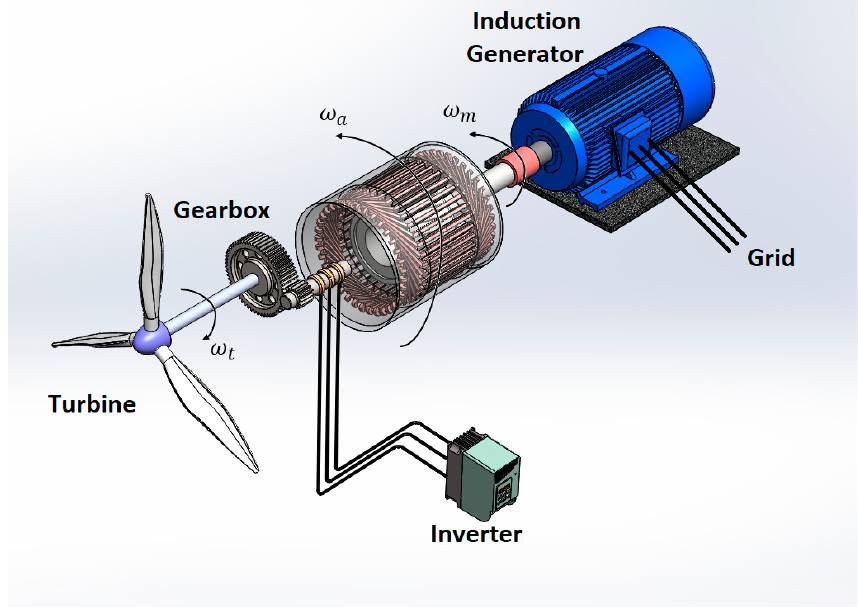
Figure 2. Schematic 3D visualization of EFR.